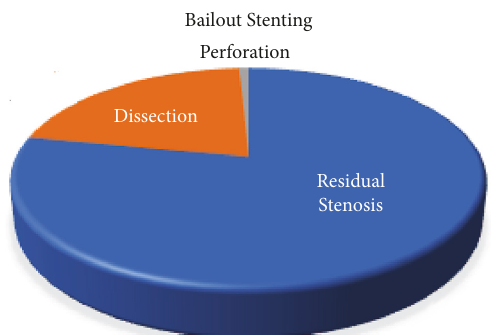
Figure 5: Reason why bailout stenting was performed. One hundred thirty-two patients who underwent DCB required bailout stenting, the majority for residual stenosis. Twenty-eight patients were because of dissection, and one patient had perforation re- quiring a covered stent. DCB � drug-coated balloons; DES � drug- eluting stents.